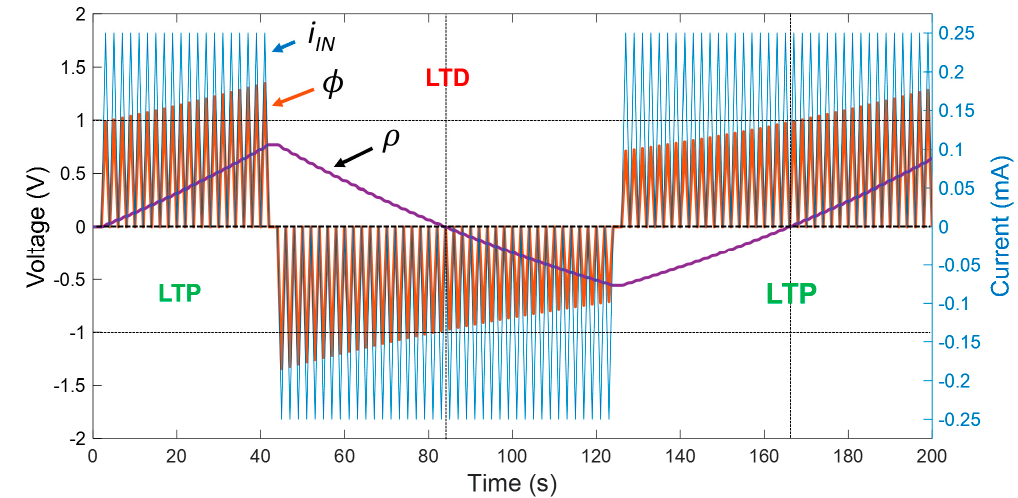
Figure 11. Pre-synaptic ( i IN > 0) and post-synaptic ( i IN < 0) current spikes applied to the meminductor, emulating neural stimuli. Long-term potentiation (LTP) and long-term depression (LTD) are reflected by the progressive increase and decrease in the TIF, respectively. Input flux ( φ ) reflects the change in the memory state.